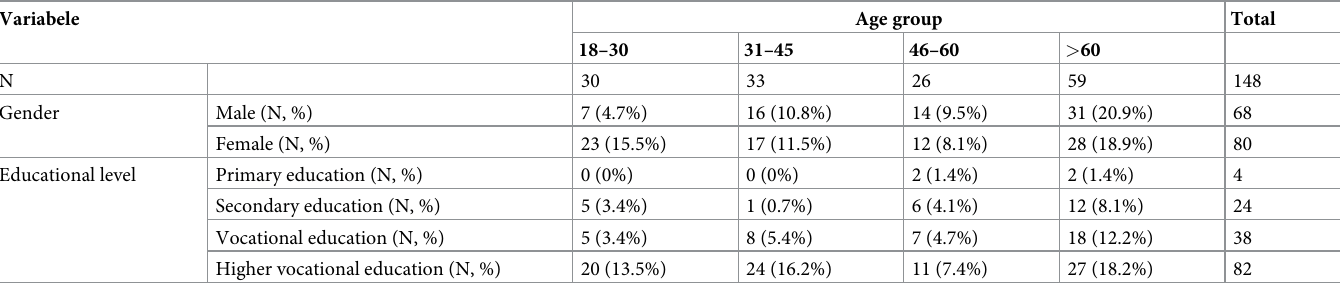
Table 4. Demographics (gender, educational level) per age